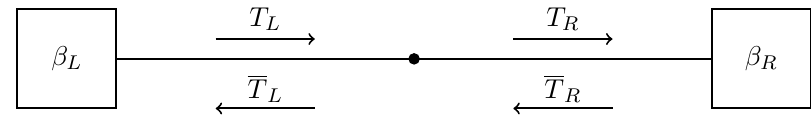
Figure 12 . Depiction of a quantum wire in a non-equilibrium steady state. The thermal reservoirs are denoted as boxes.